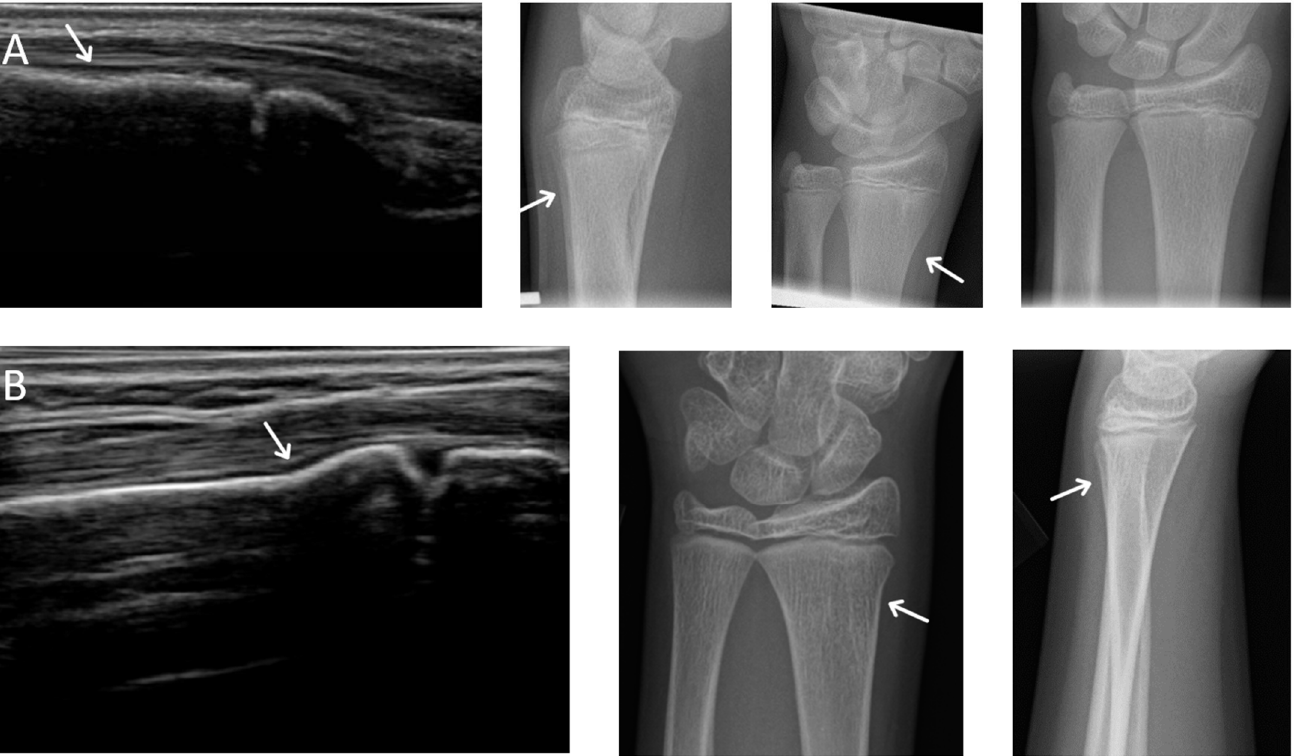
Figure 1. Possible missed fractures. ( A , B ) are dorsal longitudinal views of the distal radius of two possible X-ray false negatives. Note the excess angulation of the distal radius may represent torus fractures. The possible defect is observable on X-ray.